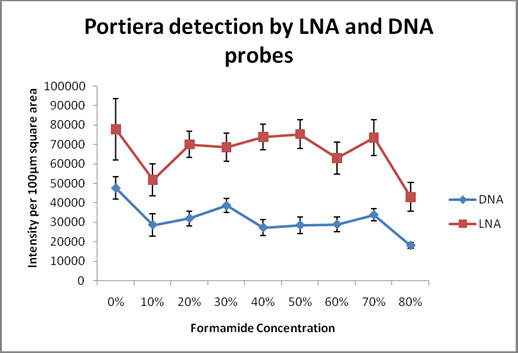
 Comparison between LNA and DNA probes while detecting the more abundant endosymbiont (Portiera ). This graph depicts signal intensity profiles of LNA and DNA probes as a function of formamide concentration after background subtraction. At the same concentration, the intensity profile of LNA probe is significantly higher than the DNA probe while detecting Portiera, an endosymbiont of high abundance. All the images were acquired at fixed camera and microscope settings for DNA and LNA with Nikon A1 confocal microscope. Fluorescence intensities were quantified by NIS elements (V 3.21.02) image analysis software (Nikon).